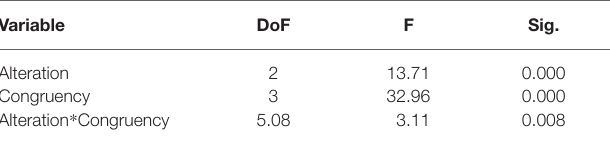
TABLE 1 | ANOVA results for hand AOI dwelling